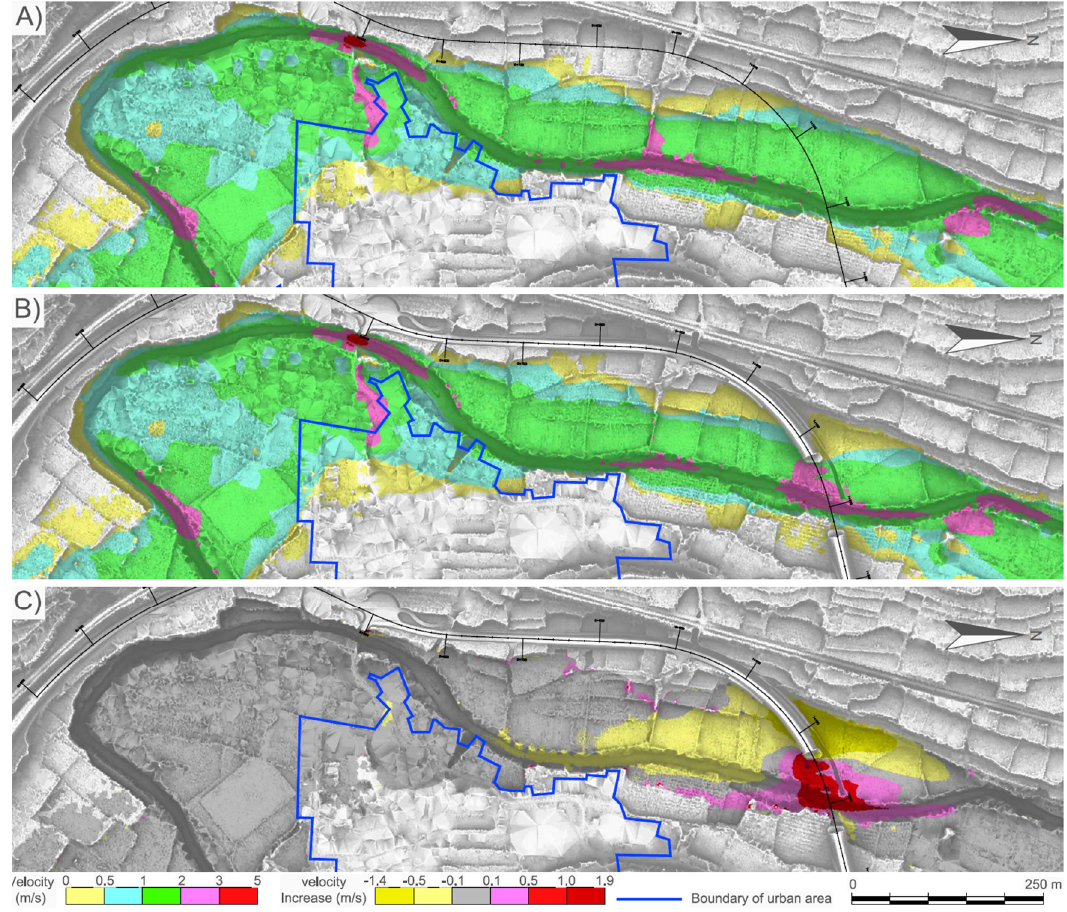
Figure 4. Velocity coverage: ( A ) initial state without bridge and ( B ) state with the option bridge 3. In ( C ), the difference between the two previous velocity coverages is shown.